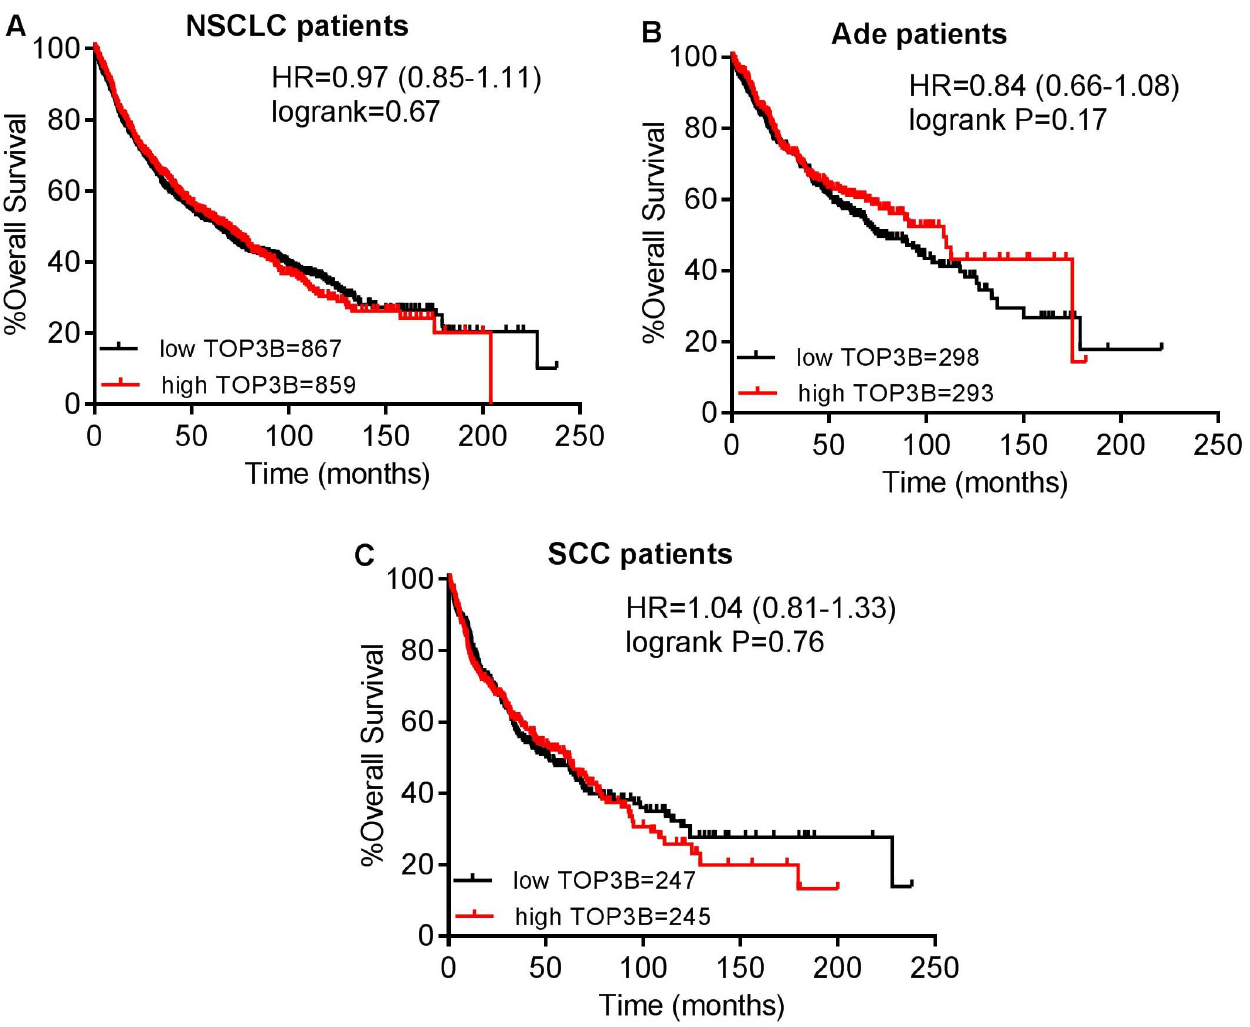
Fig 7. The prognostic value of TOP3B expression. (A) Survival curves were plotted for all NSCLC patients (n = 1726). (B) Survival curves were plotted for Ade patients (n = 591). (C) Survivalcurves were plotted for SCC patients (n = 492). Data was analyzedusing Kaplan-Meier Plotter. Patients with expressionabove the medianare indicatedin red line, and patients with expressions belowthe medianin black line. HR means hazardratio.